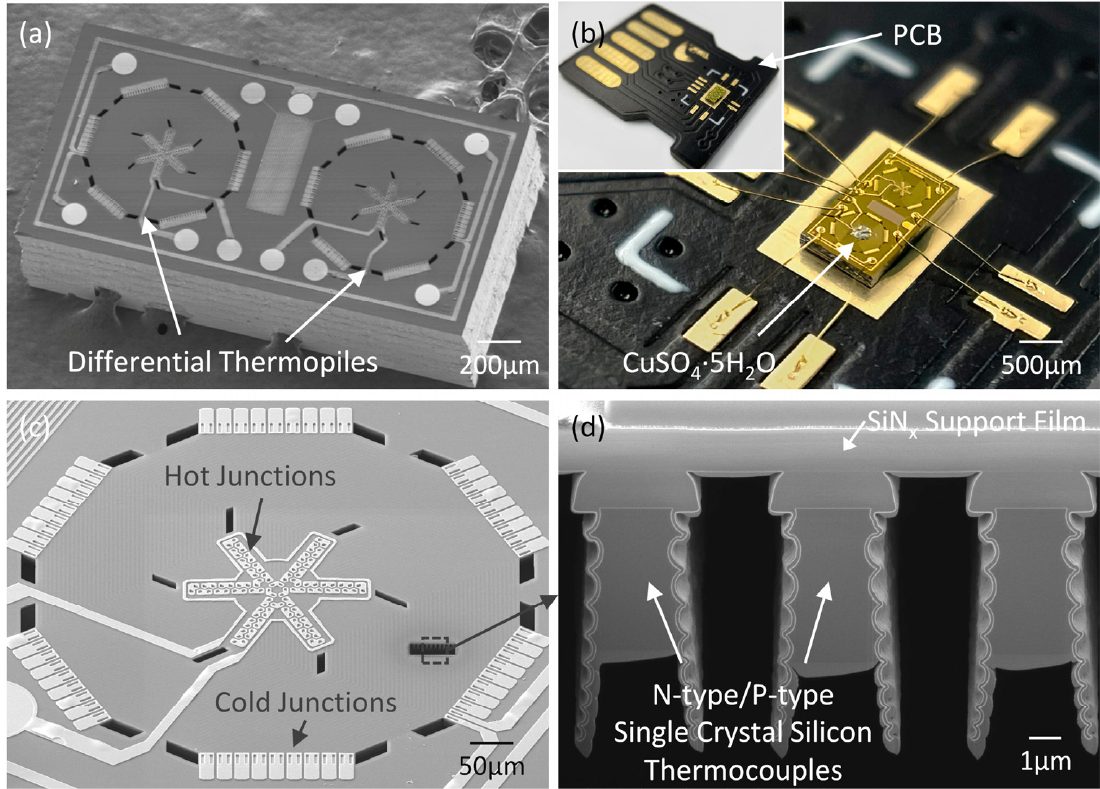
Figure 3. Image of the fabricated MEMS thermopile chips. ( a ) SEM image showing a pair of differential thermopiles on a 2 mm × 1 mm × 0.4 mm die. ( b ) Optical image of the MEMS thermopile chip after wire bonding and sample loading. ( c ) Zoomed-in view of the single thermopile showing 54 pairs of single-crystal thermocouples arranged in a spiral shape, with hot junctions in the center and cold junctions at the edges. ( d ) Cross-sectional view of the single-crystal silicon thermocouples un- derneath the SiN x film.